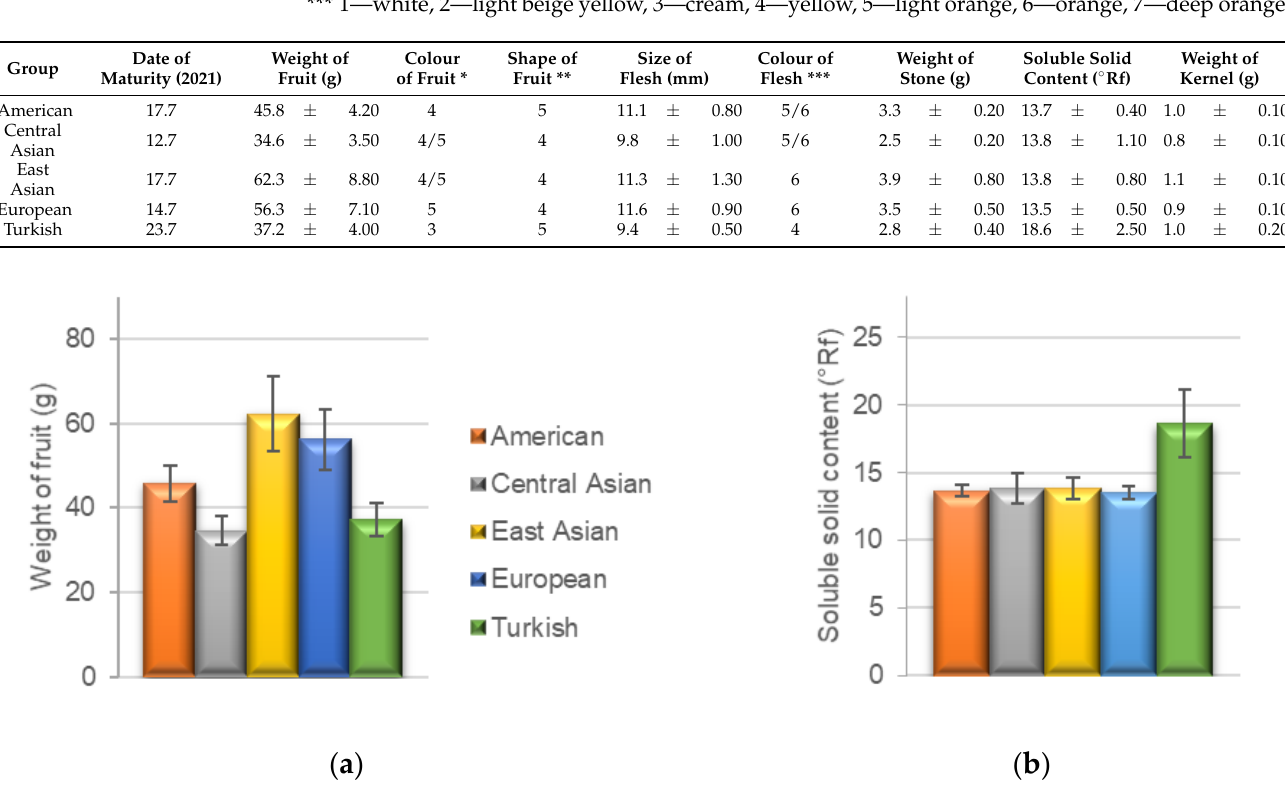
Table 2. The average pomological traits for the geographical groups of apricots. No significant differences ( p < 0.05) were detected within the pomological traits based on the Kruskal-Wallis test.